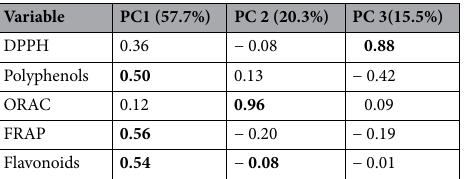
Table 1. Loadings of the variables in the space of the first 3 principal components (PC). Interpretable loadings are given in bold.